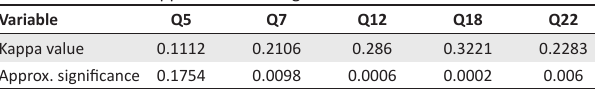
TABLE 3b: Cohen’s kappa measure of